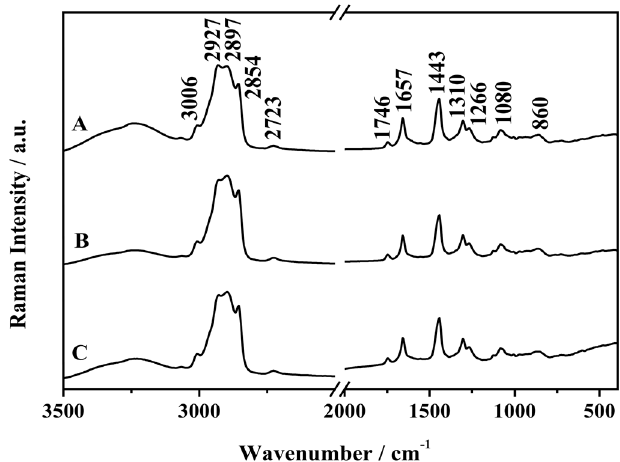
Figure 1. Average FT-Raman spectra of the frankfurters samples: (A) Turkey, (B) Mixture meat and (C)